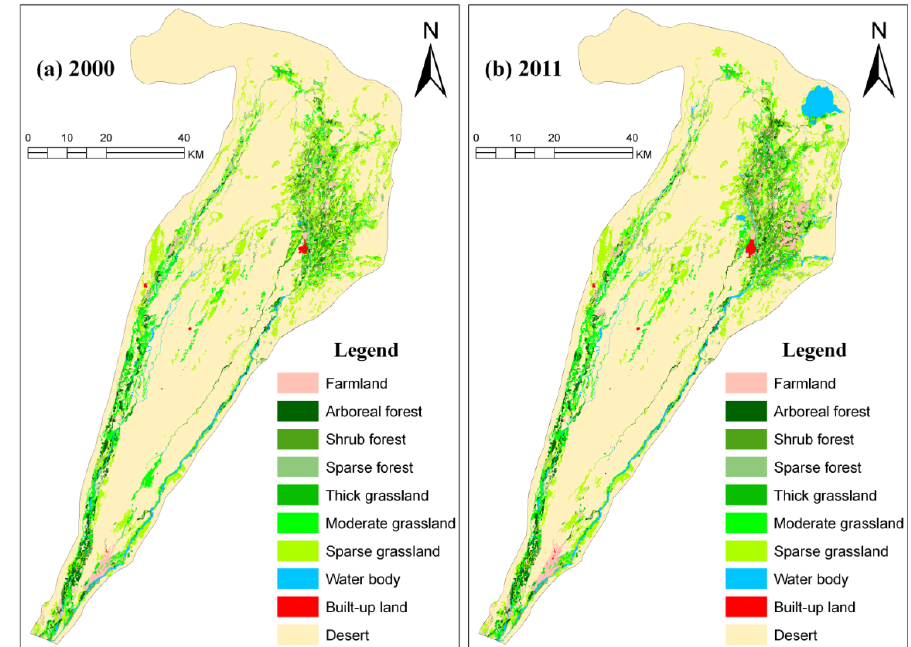
Figure 2. Land use maps of the study area in ( a ) 2000 and ( b )